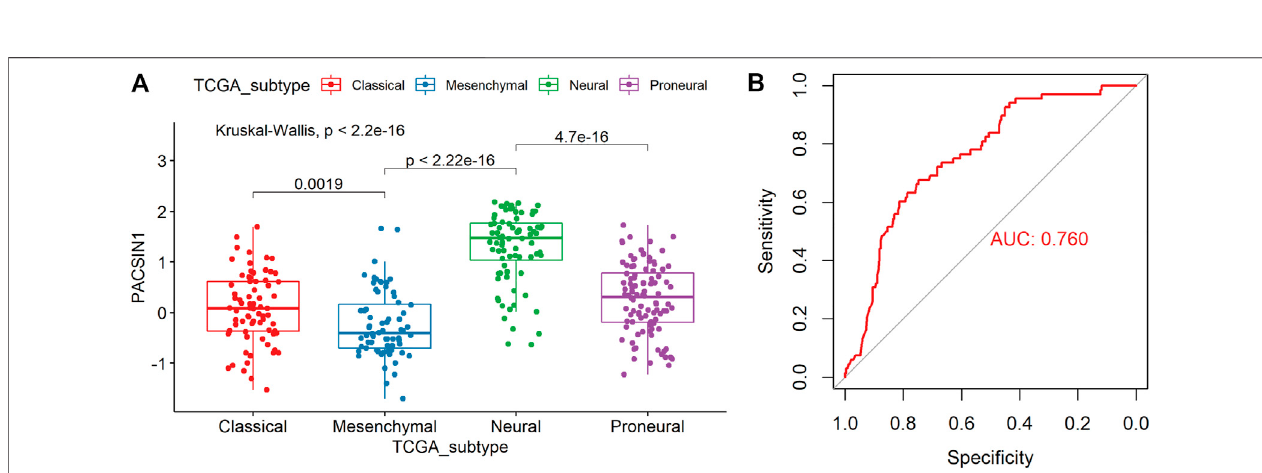
FIGURE 4 | PACSIN1 expression in different molecular subtypes de fi ned by TCGA network. PACSIN1 was decreased in mesenchymal molecular subtype in CGGA dataset (A) . ROC curve of PACSIN1 expression to predict mesenchymal molecular subtype in CGGA dataset (B) .